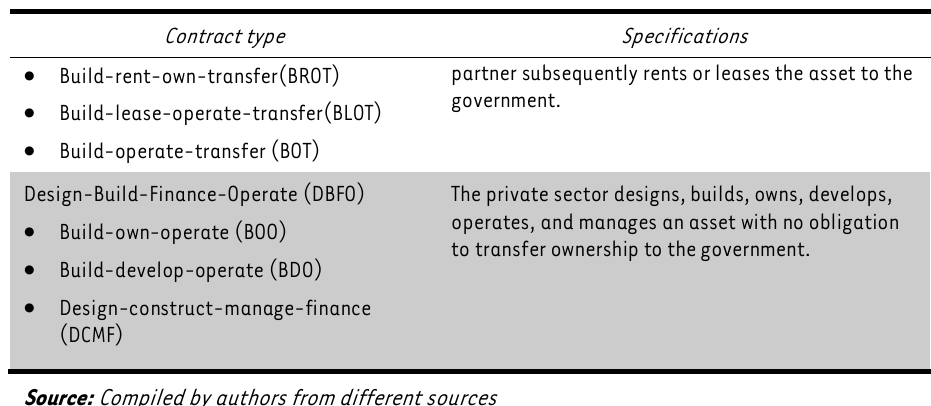
Advantages and disadvantages of PPPs Advantages Disadvantages Ease the strain on government’s balance Transaction costs associated with PPP contracts are sheet. normally high and this discourages many small potential service providers from participating in the bidding process. Introduce competition when bidding for Lack of a well-developed capital market can limit infrastructure projects takes place. the development of a viable PPP market. Restructure the public sector service